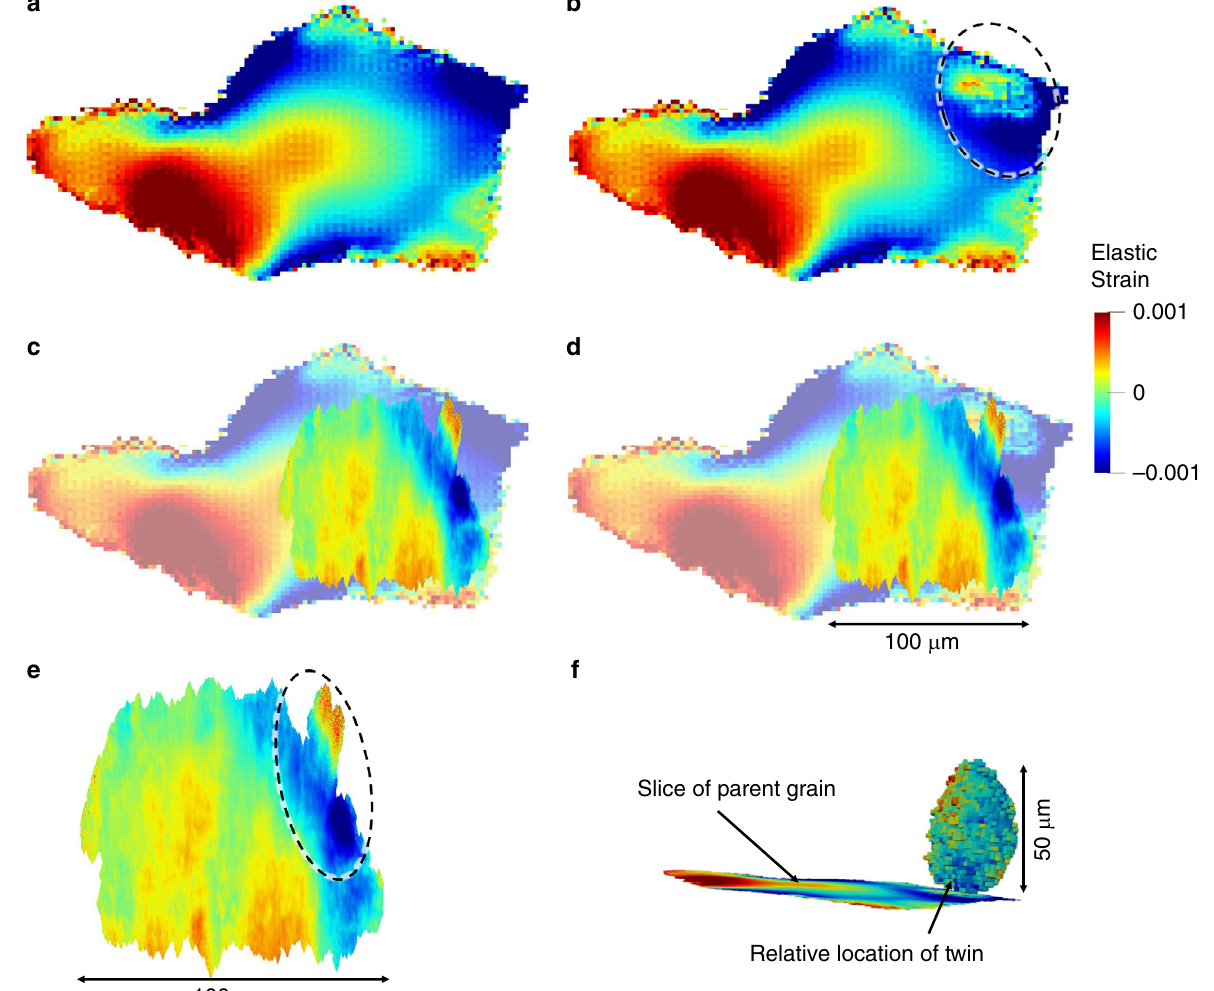
Fig. 5 DFXM and CP-FFT Comparison – Elastic Strain. ( a ) CP-FFT model result of elastic strain without twin instantiation; ( b ) with twin instantiation. ( c ) CP-FFT model from a with DFXM overlay from e . ( d ) CP-FFT model from b with DFXM overlay from e . ( e ) Elastic strain from DFXM combined mosaicity and elastic strain scan. ( f ) Relative position of twin boundary to the 2D slices a – e . All strains are of the elastic strain component normal to the (220) planes of